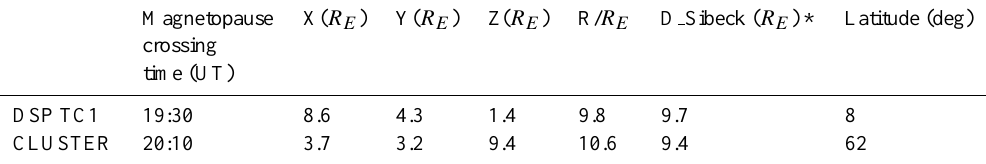
Table 2. Positions of Cluster and DSP TC1 on 22 February 2004 at the time they cross the magnetopause. The 4 Cluster spacecraft were separated by only 200km. D Sibeck is the location of the magnetopause sub-solar point estimated with the Sibeck et al. (1991) model.